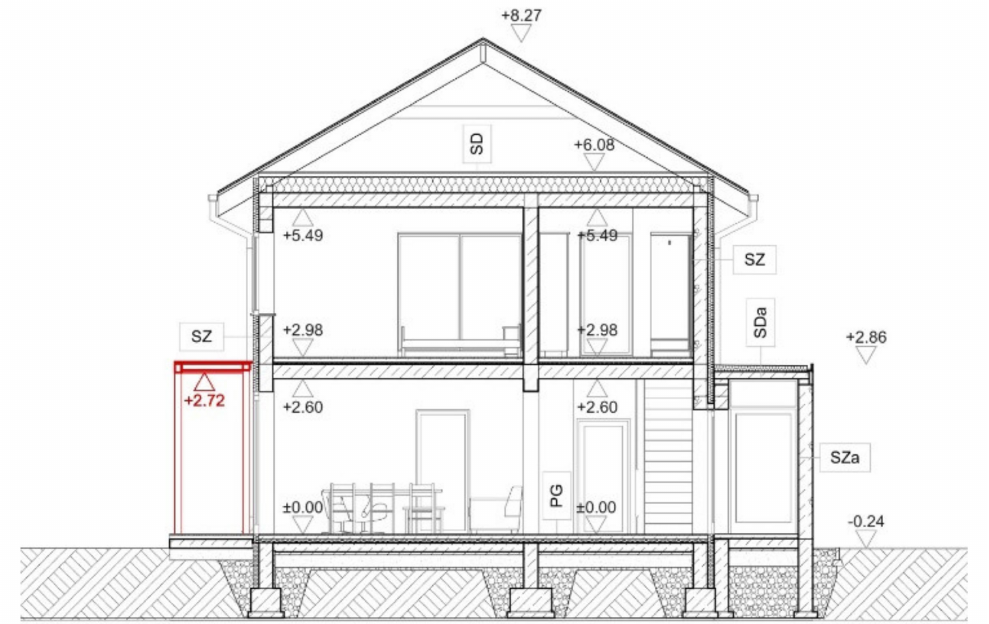
Figure 6. Model B2, B3. Section A-A. Scale of 1:100. The canopy used in model B2 is marked in red. Source: own study using ARCHICAD software. Ground floor plan and cross-section of the SB (straw-bale) building are shown in Figures